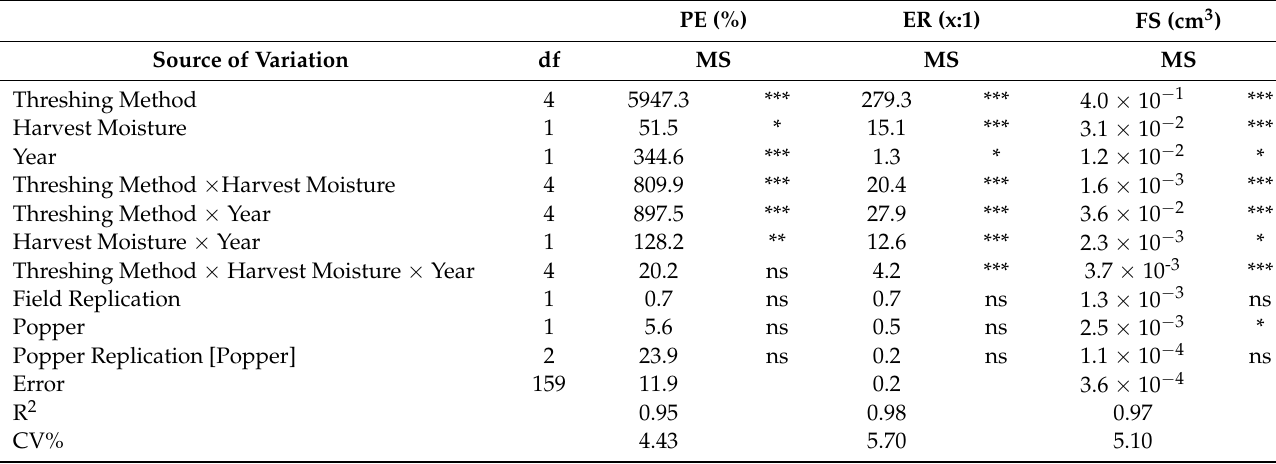
Table 2. Analysis of variance for popping efficacy (PE), expansion ration (ER) and flake size (FS) from the grain of a Texas A&M pop sorghum hybrid grown in College Station, Texas in 2019 and